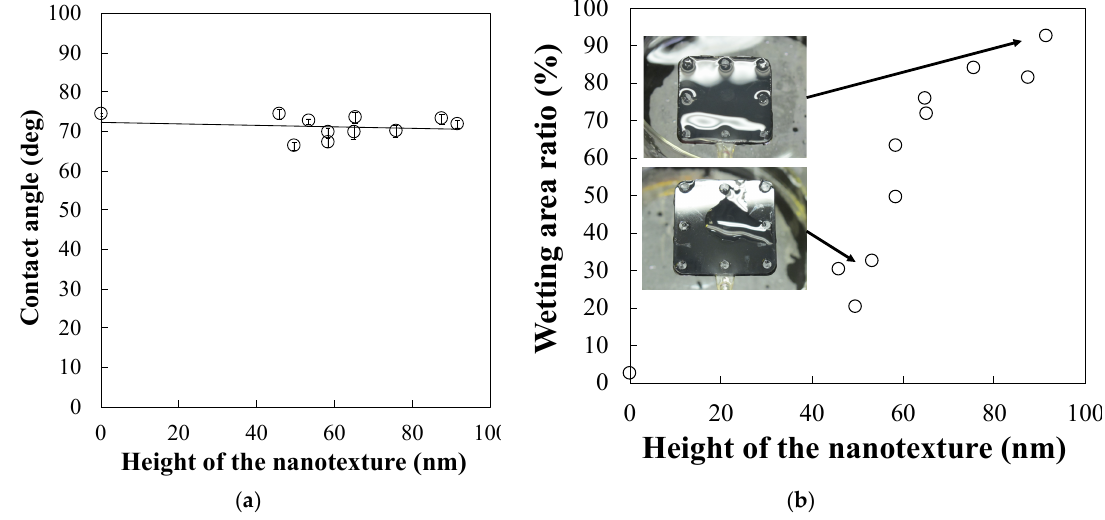
Figure 6. ( a ) Contact angle as a function of the height of the nanotexture and ( b ) wetting behaviour using the water